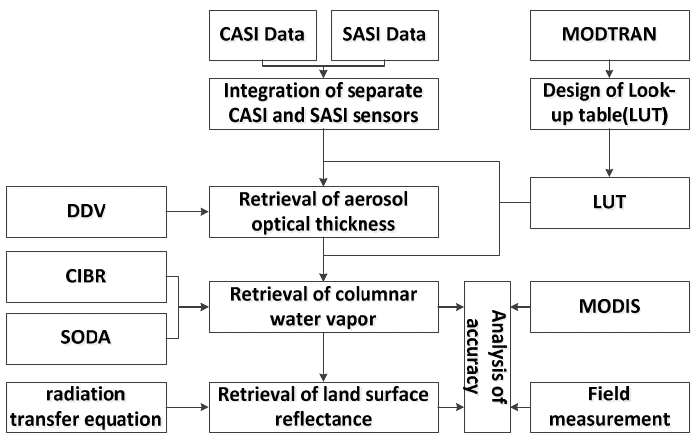
Figure 7. Flow chart for land surface reflectance retrieval.